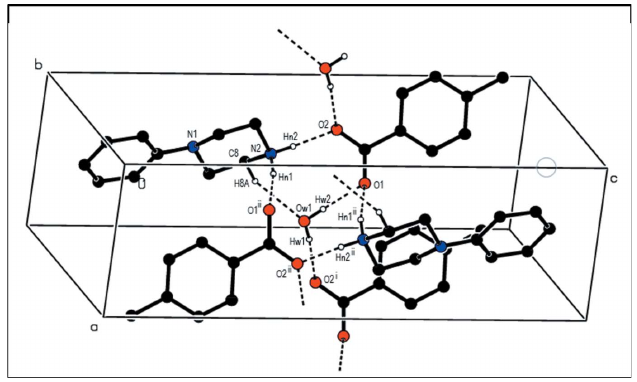
Figure 7 Part of the crystal structure of compound ( III ) showing the formation of a hydrogen-bonded chain of rings parallel to [001]. Hydrogen bonds are drawn as dashed